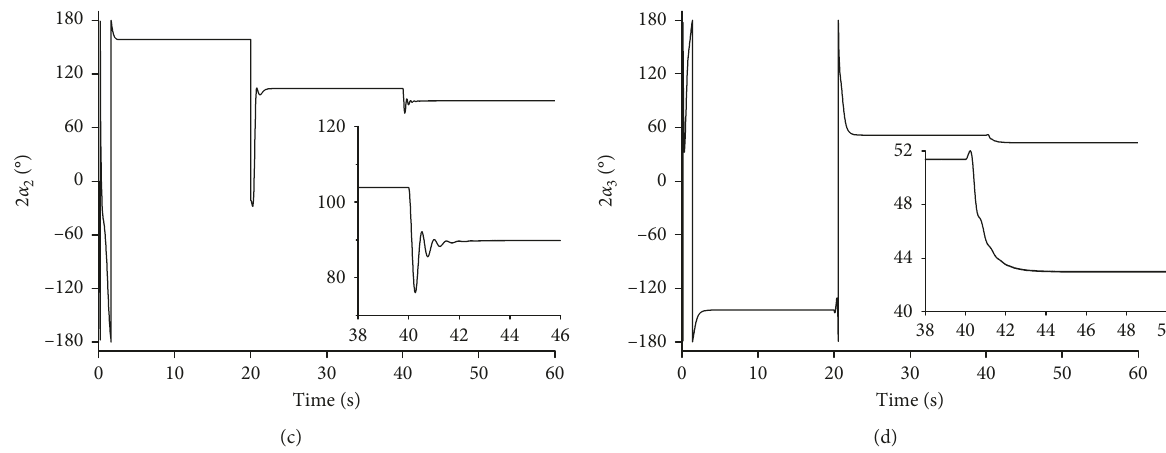
, η . 75 , η . 5. (a) Rotational velocities of the four motors; (b) phase 1 (cid:31) η 2 (cid:31) 1 3 (cid:31) 0 4 (cid:31) 0